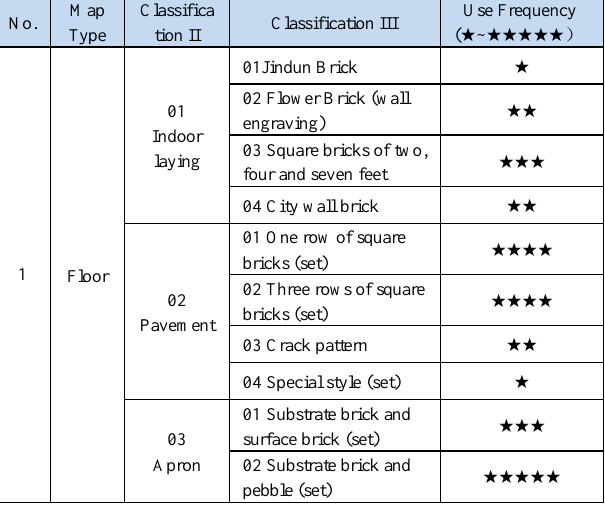
Table 1. Example of Classification List in Map Library